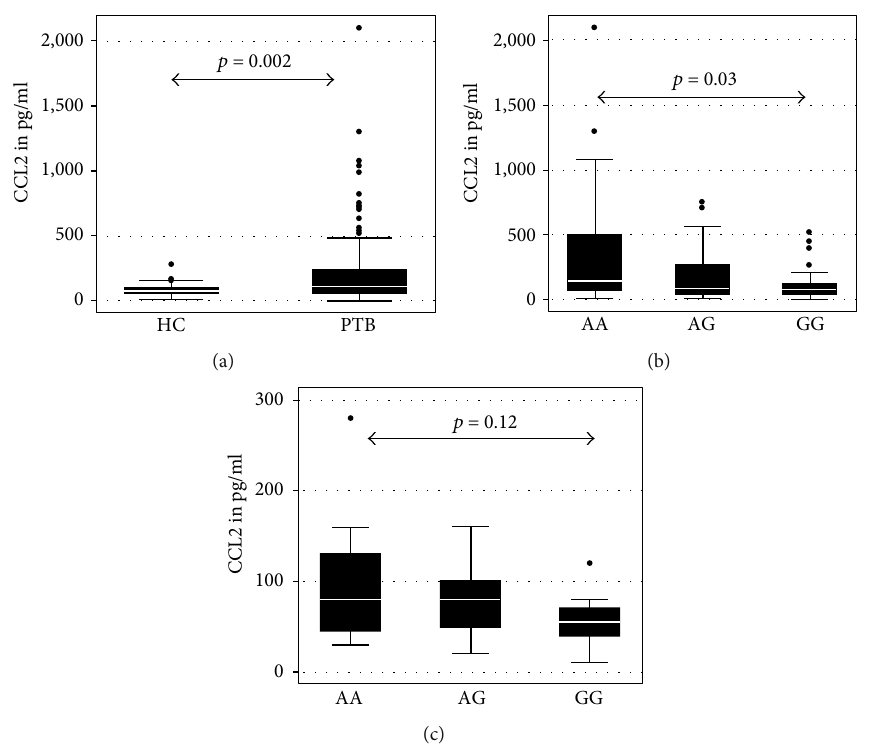
Figure 1: Comparative analysis of serum CCL2 level in PTB patients and healthy controls. Serum CCL2 was measured by sandwich ELISA using Duoset from R&D Systems, USA, in pulmonary TB patients and controls. The level was expressed as pg/ml on the Y -axis and represented as box and whisker plot. Each dot above the vertical box plot represents the outside value of one subject. Each box is with whiskers on both sides with upper and lower adjacent values, respectively. The box shows the 75 th , median, and 25 th percentile values from the upper hinge to lower hinge, respectively. Subjects are represented on the X -axis. HC: healthy controls; PTB: pulmonary TB patients; AA: subjects with CCL2-2518AA genotypes; AG: subjects with CCL2-2518AG genotype; GG: subjects with CCL2-2518GG genotypes. (a) For comparison of CCL2 level between HC and PTB patients. (b) For comparison of the CCL2 level among PTB patients having various CCL2 genotypes. (c) The comparison of the CCL2 level among HC having various genotypes. Pairwise comparison was made by the Wilcoxon rank-sum test, and comparison of groups was done by the Kruskal-Wallis equality of population rank test. p values are shown above the box